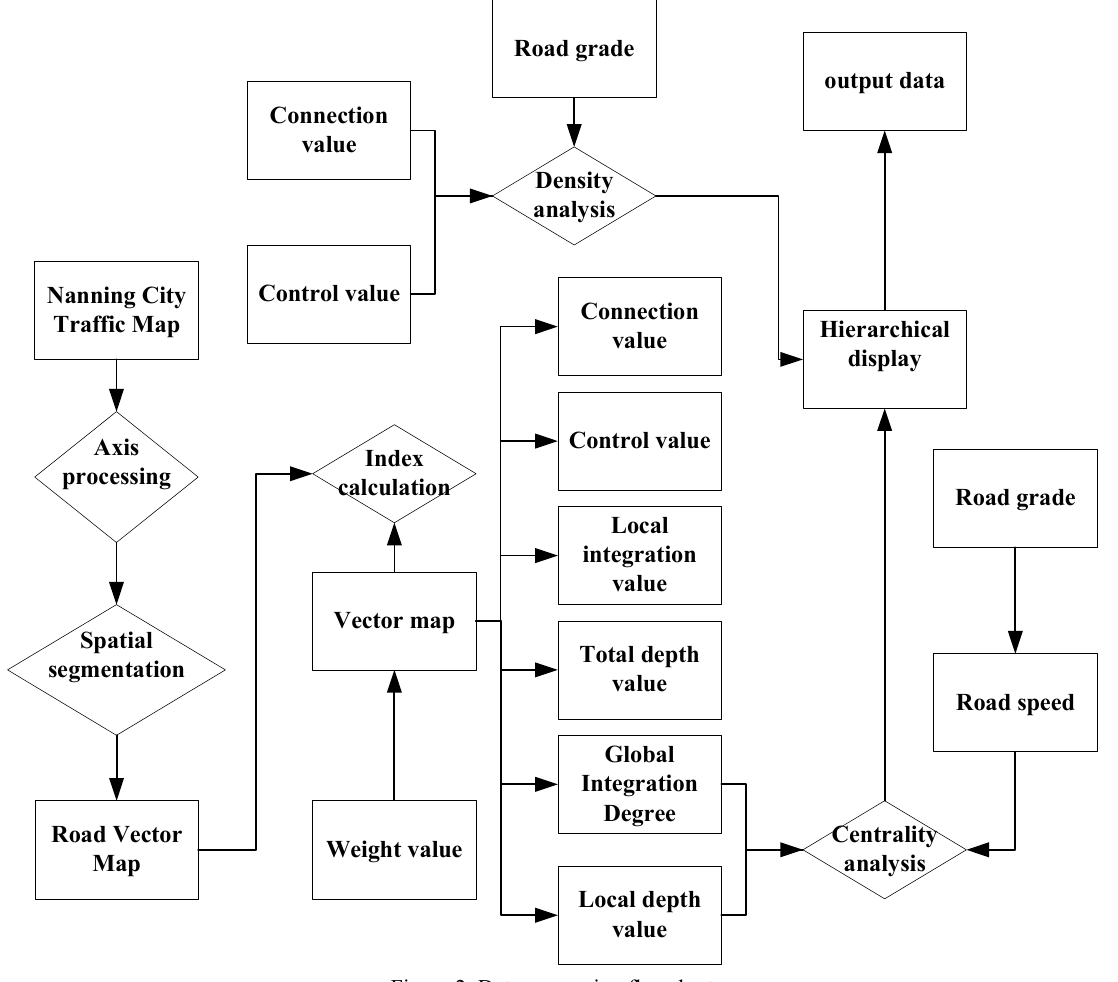
Figure 2. Data processing